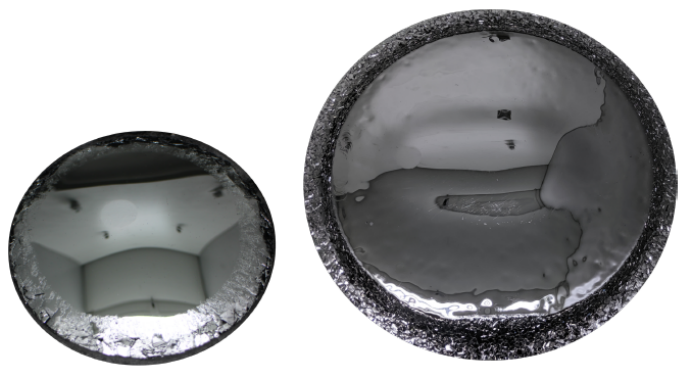
Figure 14. 100 mm ( left ) and 150 mm ( right ) 4H-SiC